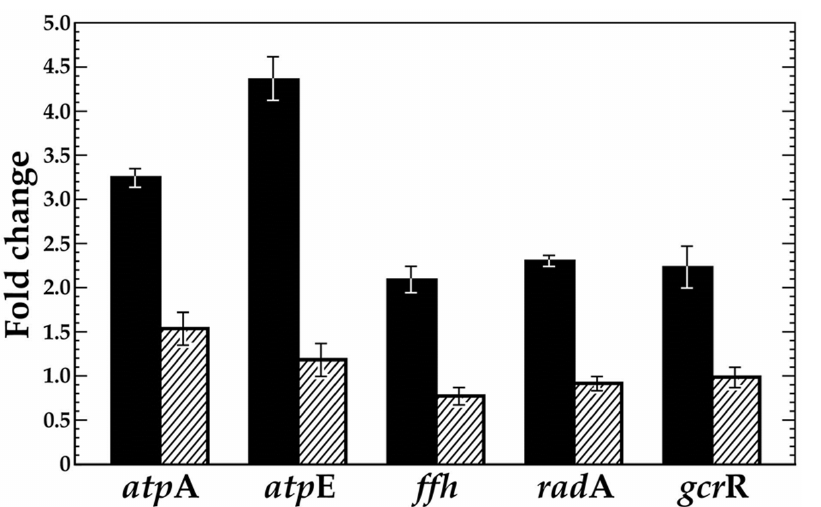
Fig. 6. VicK has a significant impact on transcription of known ATR-related genes in S. mutans . qRT- PCR was performed to reveal fold-change in gene expression at pH 5.5 versus 7.5 with cDNAs derived from S. mutans UA159 (solid black bars) and a vicK insertion-deletion mutant (SmuvicK) (striped bars). Error bars represent ¡ std. errors of the average expression values derived from at least 3 independent experiments. Student t-tests confirm that all genes are significantly down-regulated in the VicK mutant relative to the UA159 wild-type progenitor strain (p , 0.001).